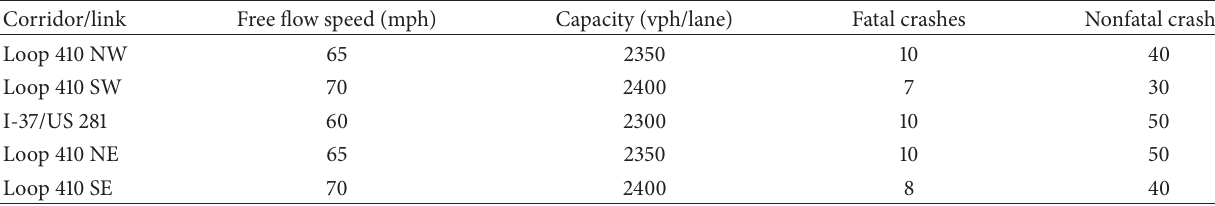
Table 1: Example network parameters.